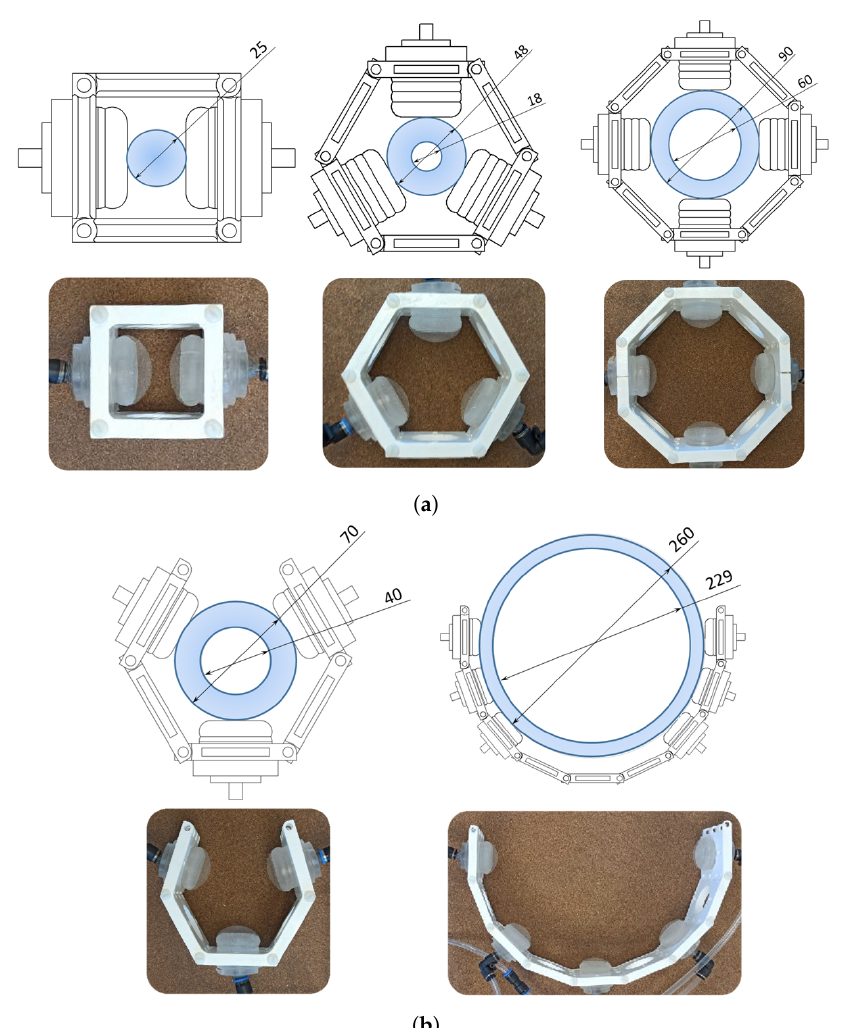
Figure 5. Examples of soft grippers obtained from the proposed design approach: ( a ) closed gripper configurations; and ( b ) open gripper